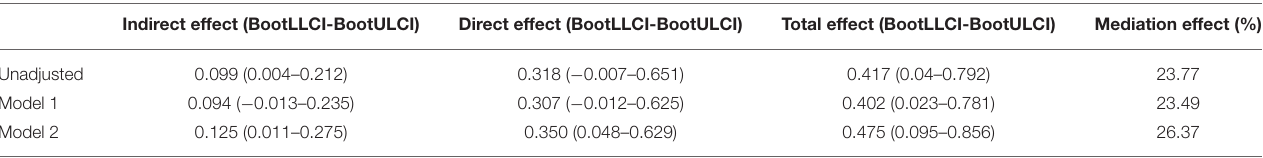
TABLE 4 | Mediation analysis of the effect of the total cSVD burden on the PSD. Indirect effect (BootLLCI-BootULCI)